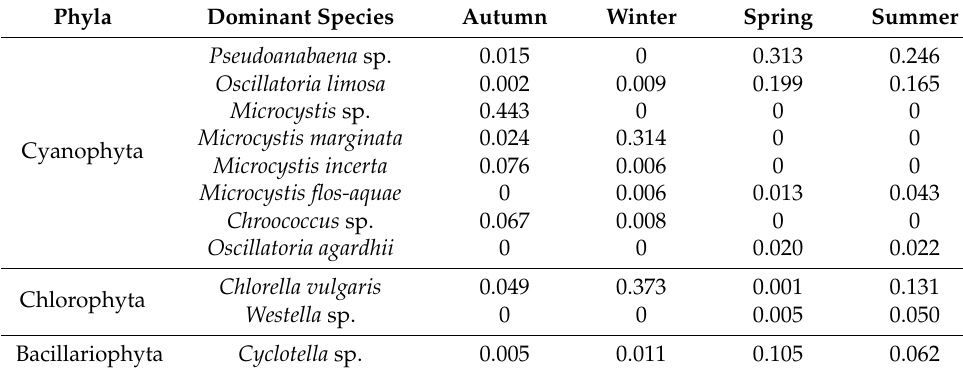
Table 2. Dominant species and dominance values for each season.